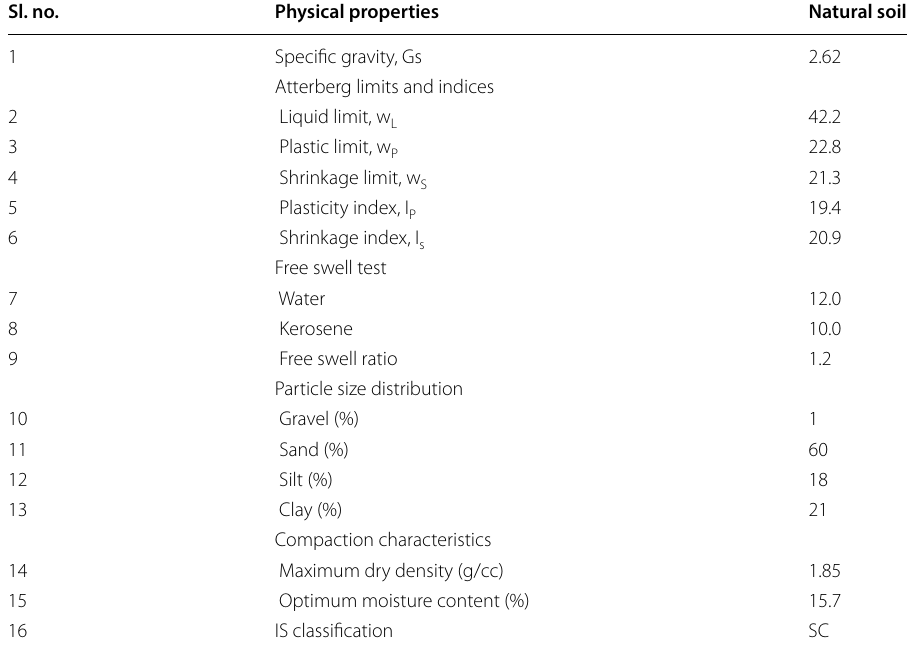
Table 1 Physical Properties of Soil used in the present study Sl.